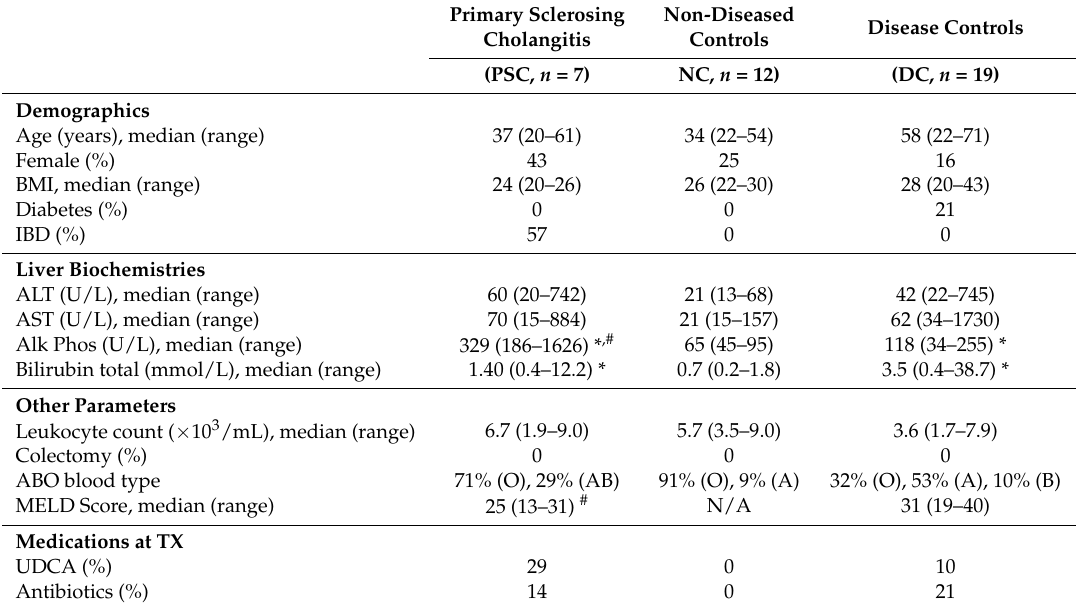
Table 1. Clinical characteristics of study